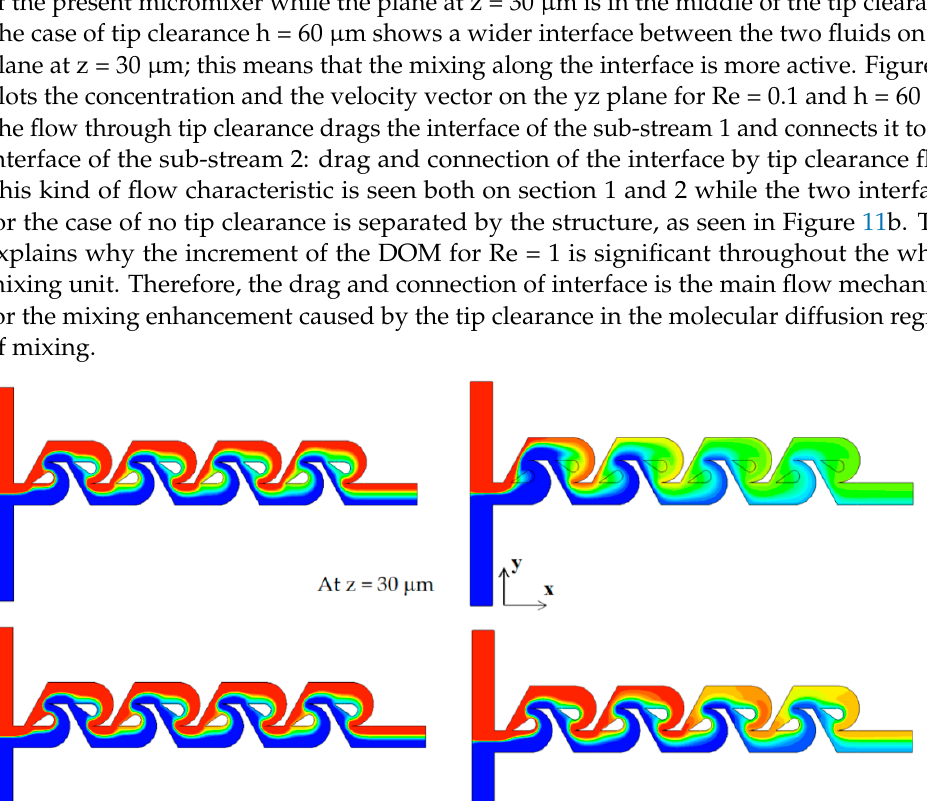
( b ) Figure 12. Evolution of mixing and velocity vector on the yz planes for Re = 0.1: ( a ) tip clearance h = 60 μ m and ( b ) no tip clearance. As the Reynolds number increases, the convective mixing becomes significant, and the mixing enhancement by tip clearance is obtained in a different way. Figure 13 com- pares the concentration contours on the xy planes for the Reynolds number of Re = 5. For the case of tip clearance, the interface between the two fluids appears wavier and multiple times and is a result of the mixing enhancement. The difference caused by tip clearance is more obvious on the plane at z = 100 μ m. Figure 14 compares the concentration contours with the corresponding velocity vector on the two yz planes for Re = 5: section 1 and 2. For the case of no tip clearance, a vortex forms on the cross-section 1, and develops into a pair of two counter-rotating vortices on the cross-section 2.